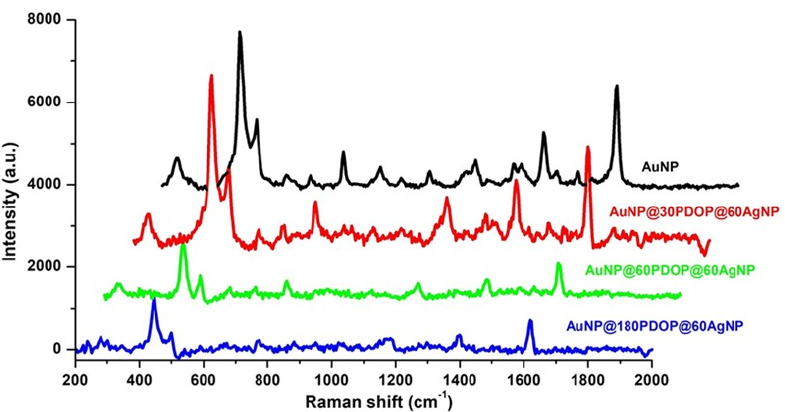
Figure 11. Effect of PDOP polymerization time (i.e., PDOP thickness) on SERS effect for 60 min of silver reduction time. Representative Raman measurements of the bimetallic core–shell NP system for different PDOP deposition times (numbers indicate deposition times in min). The final concentration of MB for Raman measurement is 10 −5 M.